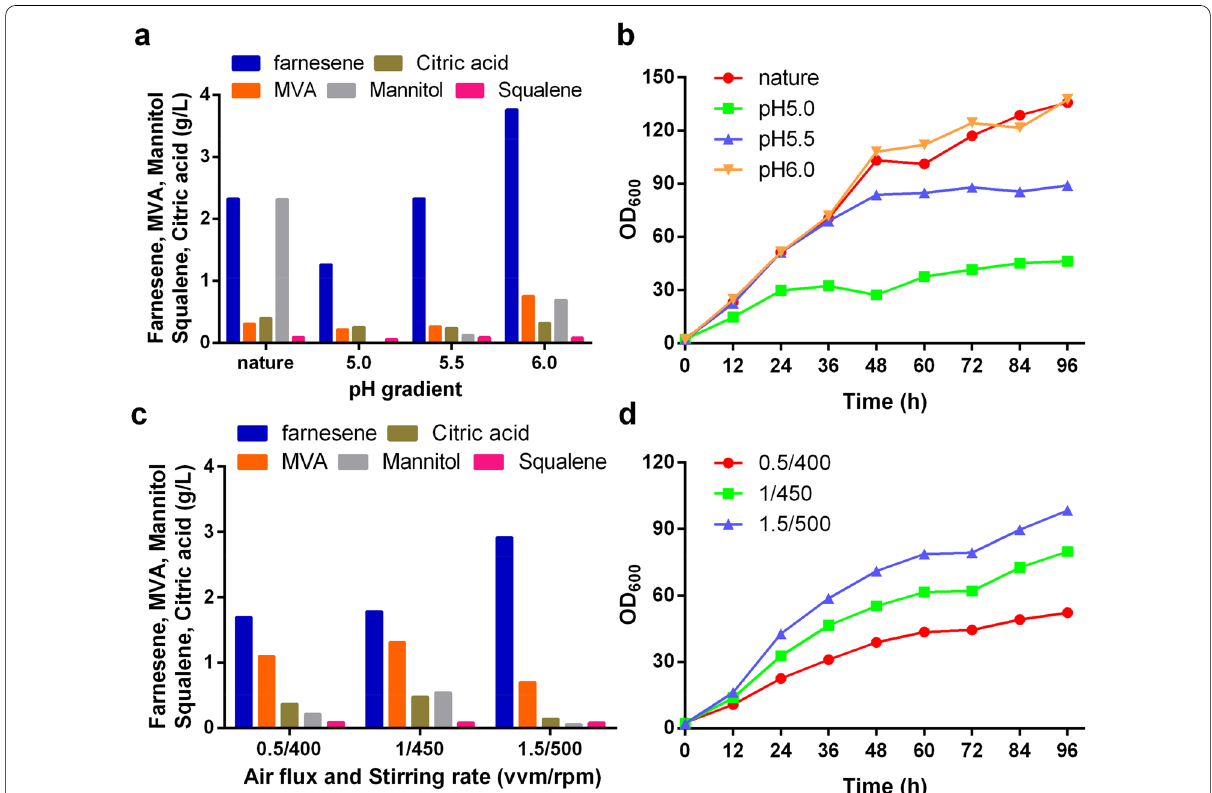
Fig. 5 Optimization of pH, air flux and stirring rate for fermentation of strain F10 in a bioreactor. a Titer of α-farnesene and metabolite accumulation at different pH. b Growth curve at different pH during fermentation. c Titer of α-farnesene and metabolite accumulation at different air flux and stirring rate. d Growth curve at different air flux and stirring rate during fermentation. α-Farnesene and metabolites were detected after 96 h of fermentation in a 1-L bioreactor containing 800 mL YP medium with oleic acid. This experiment was performed with n